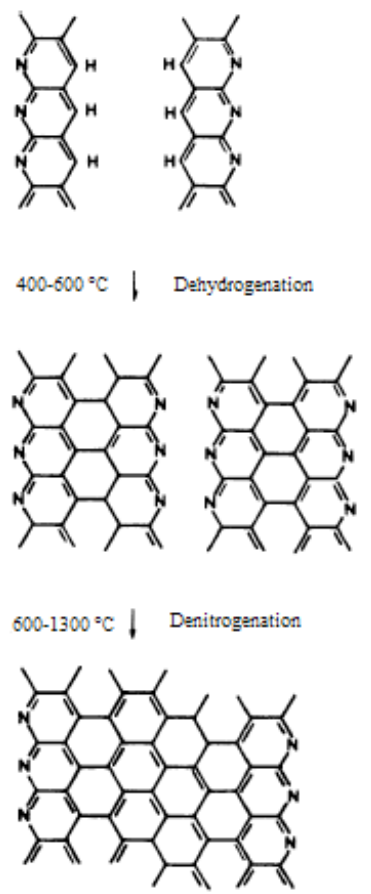
Figure 5. Schematic formation of the graphite structure [57] (Reproduced with permission from Elsevier, ©